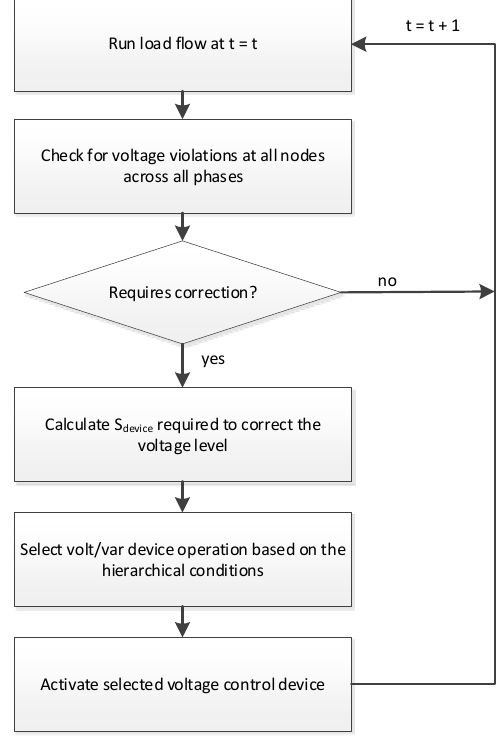
Figure 2. Flowchart of the proposed volt/var control